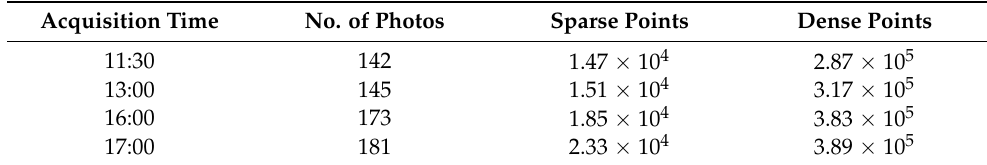
Table 1. An example of the relation between the number of acquired photos during the IRT spring survey and number of points characterizing TIR sparse and dense point